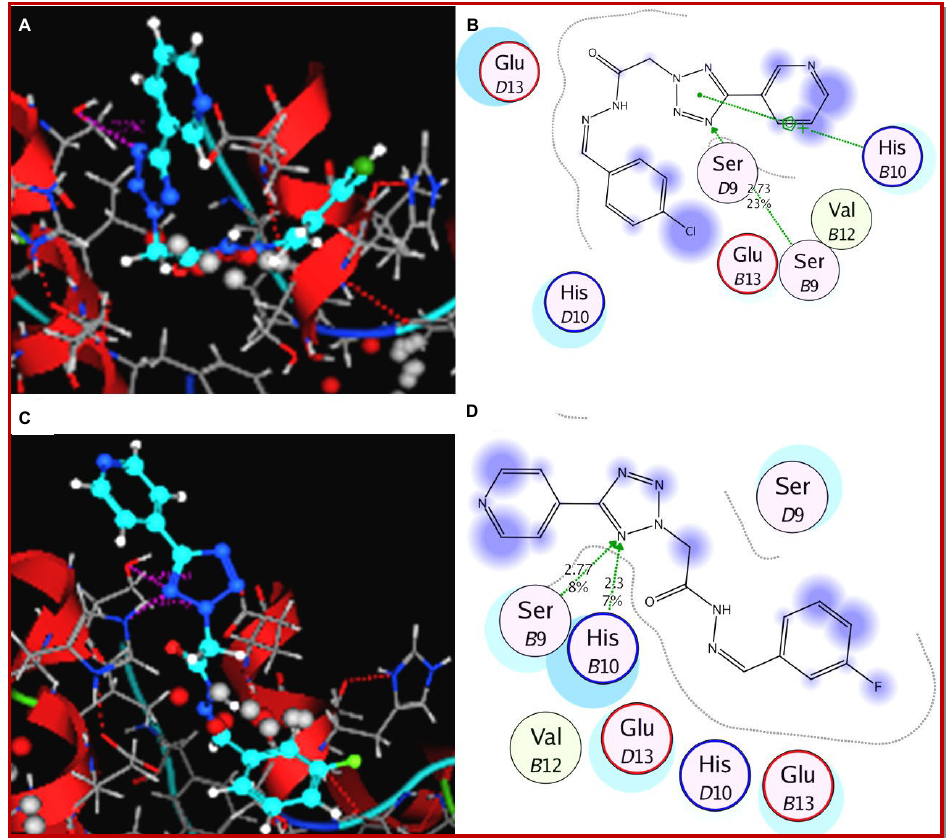
Figure 4: Molecular docking analysis of (3QE6). A, C) Docking pose of 9a and 10l in 3D space, molecule is shown in cyan color (ball n stick model) key residues are shown in elemental color (stick mode). The receptor is shown in red ribbons and cartoons. Hydrogen bonding interactions are shown in dashed purple lines. B, D) Docking pose of 9a and 10l in 2D space, hydrogen bond- ing interactions are shown in green colored dashed